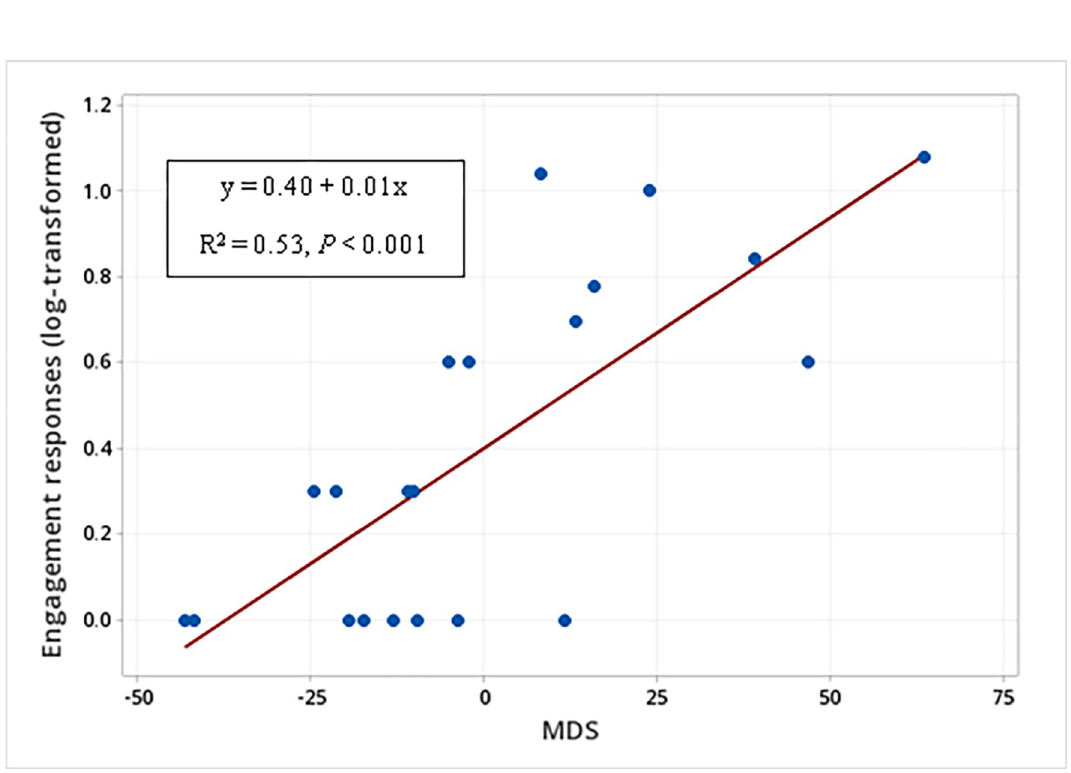
Fig 11. Relationship between the sender’s social rank (MDS) and the occurrence of engagement responses (log-transformed). Occurrence of engagement responses to multimodal signals when white-lipped peccaries (N = 21) were displaying threatening